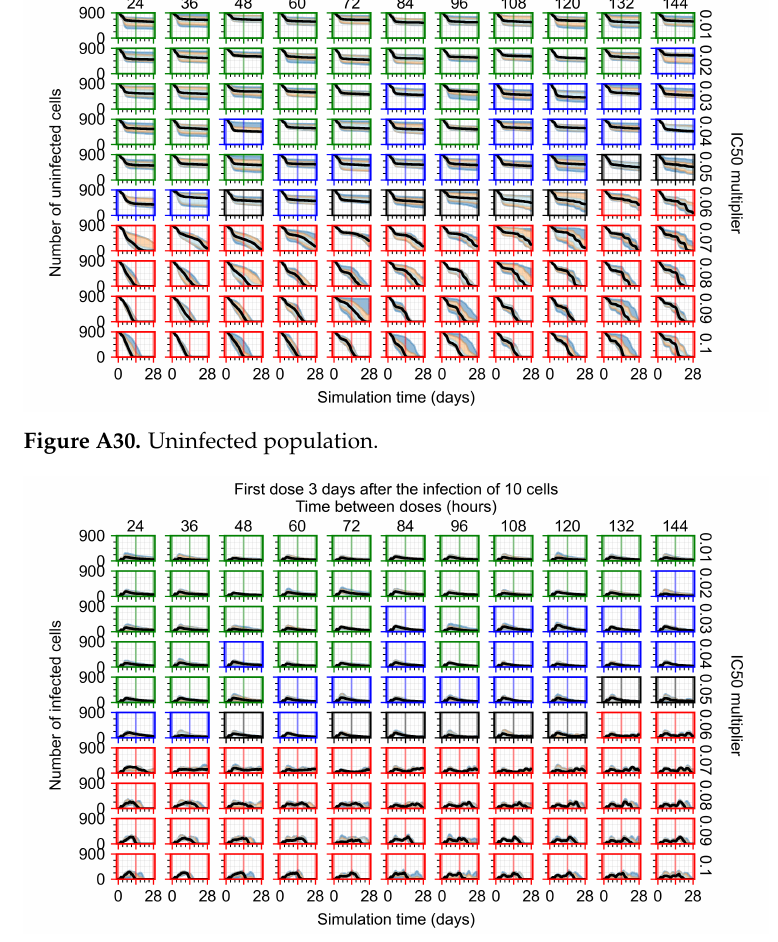
Figure A31. Infected (eclipse phase)